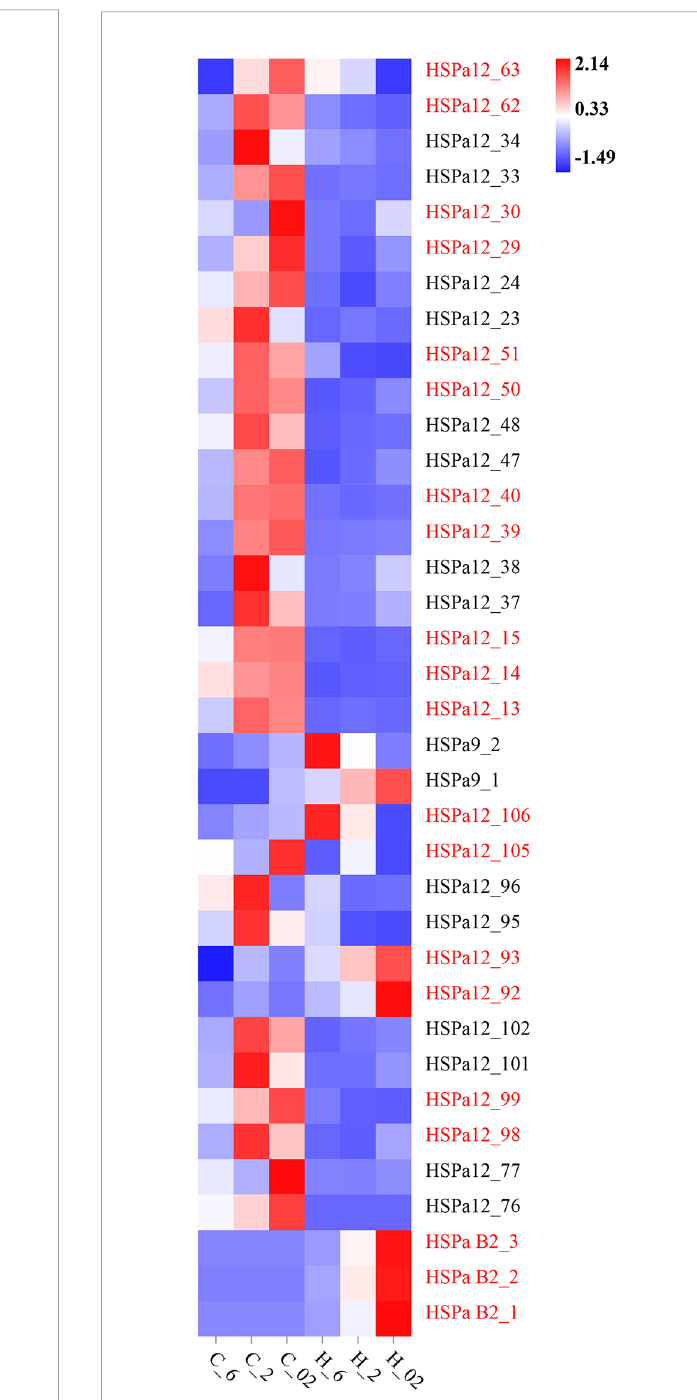
FIGURE 8 | In silico gene expression analysis of M. mercenaria tandem duplication MmHSP70 genes under heat, hypoxia and combined stress. The colour scale represented Z-score. C_6: 20°C, 6 mg/L DO, control; C_2: 20° C, 2 mg/L DO, moderate hypoxia stress; C_02: 20°C, 0.2 mg/L DO, severe hypoxia stress; H_6: 35°C, 6 mg/L DO, heat stress; H_2: 35°C, 2 mg/L DO, heat plus moderate hypoxia stress; H_02: 35°C, 0.2 mg/L DO, heat plus severe hypoxia stress. The tandemly duplicated gene pairs were shown by adjacent two or three genes with the same